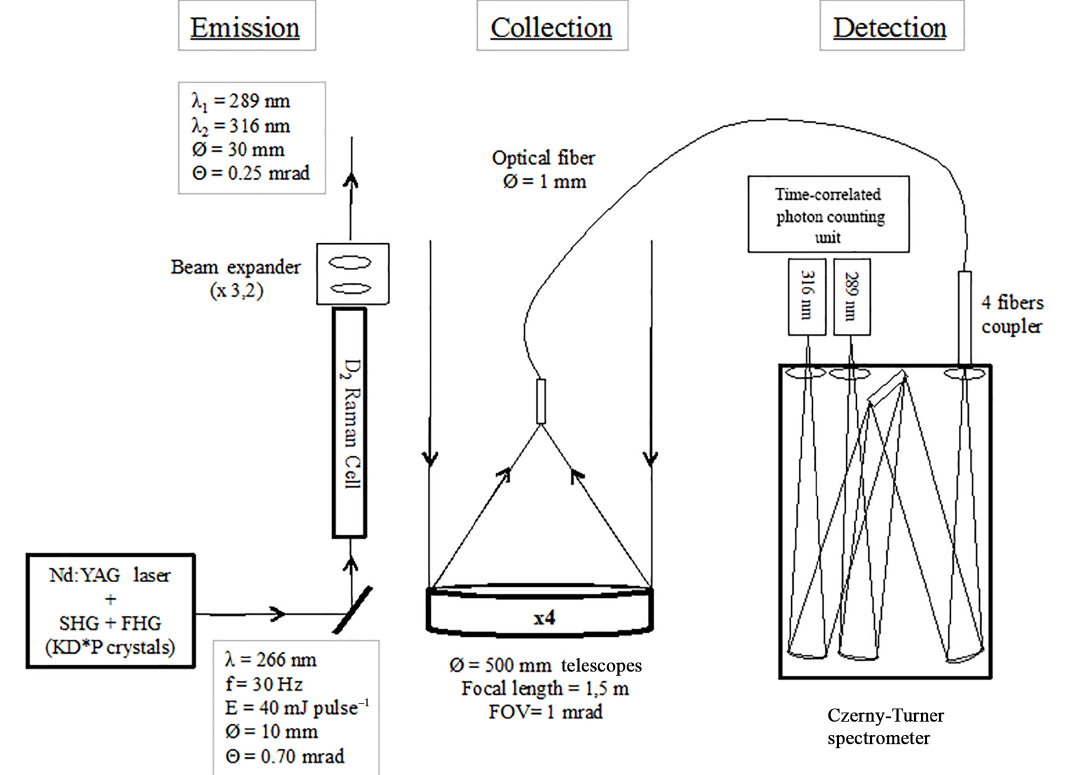
Figure 2. LIO3T instrumental